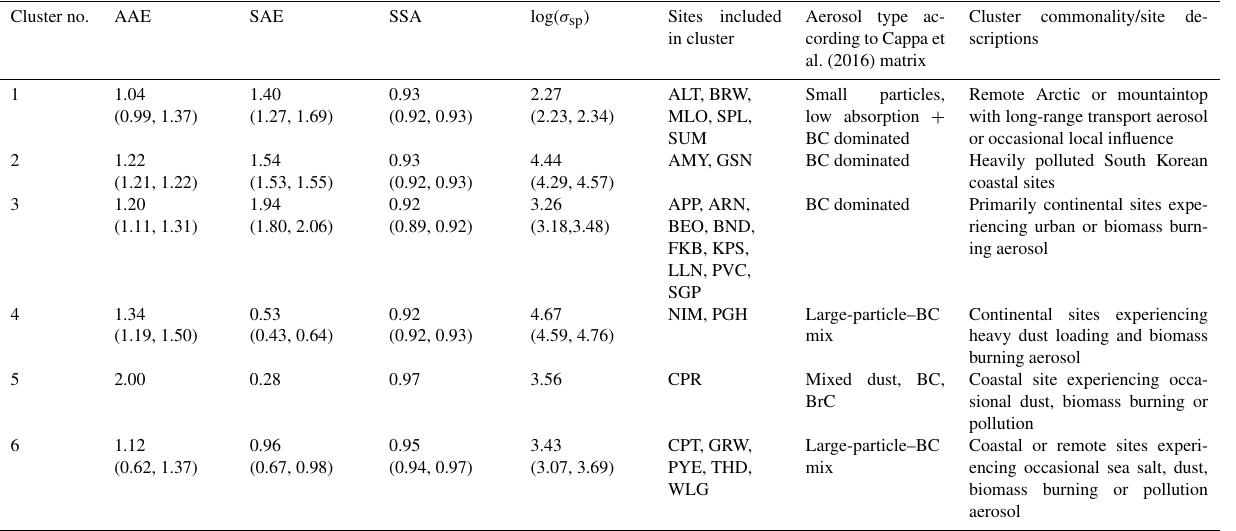
Table 4. Median AAE, SAE, SSA and log( σ sp ) values (along with corresponding interquartile spread) for each cluster resulting from the cluster analysis.